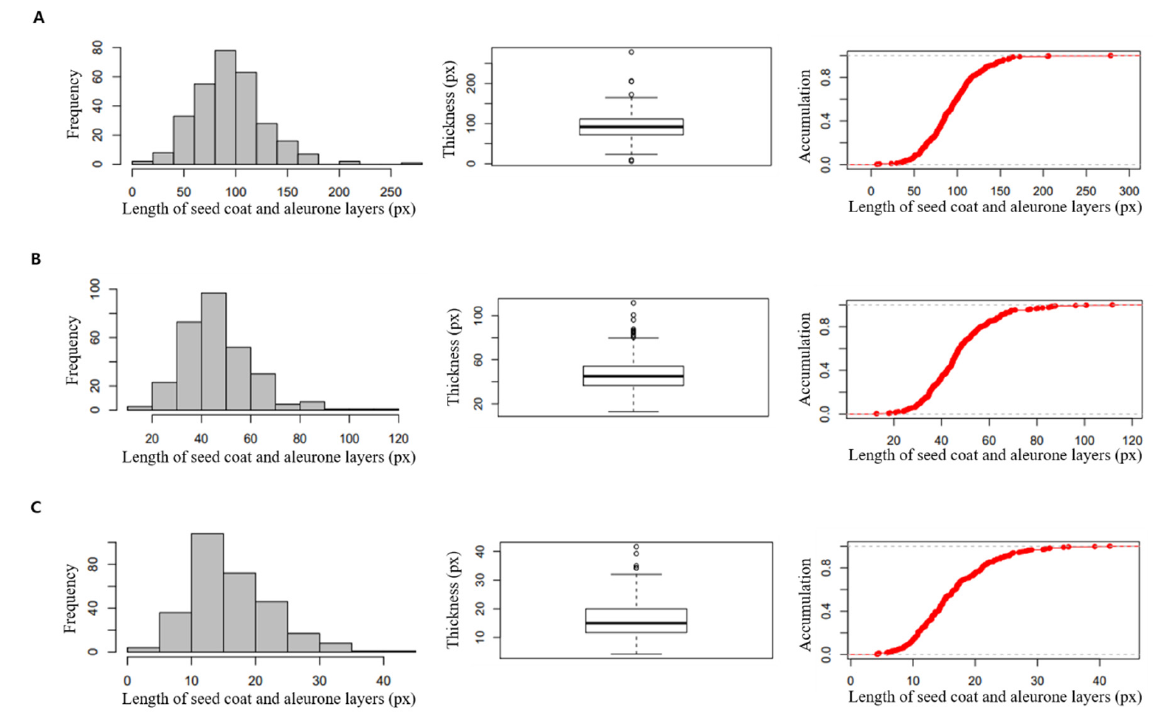
Figure 2. Phenotypic distributions and box plots of seed coat and aleurone layer thickness by region with 294 rice resources. ( A ) the thickest part, ( B ) middle part, and ( C ) the thinnest part. Table 1. Summary of statistics for thickness of seed coat and aleurone layers by region in the 294 rice genetic resources. Thickest Part of Middle Part of Aleurone Thickest Part Parameter Aleurone Layers Layers